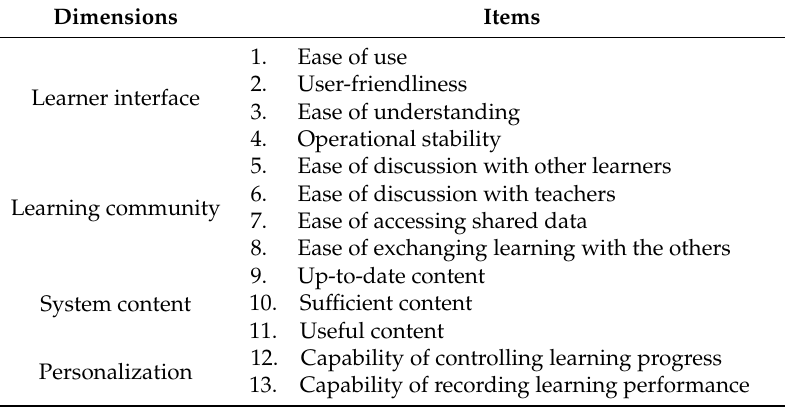
Table 1. Four dimensions and 13 items on the web-based e-learning system (WELS) questionnaire.